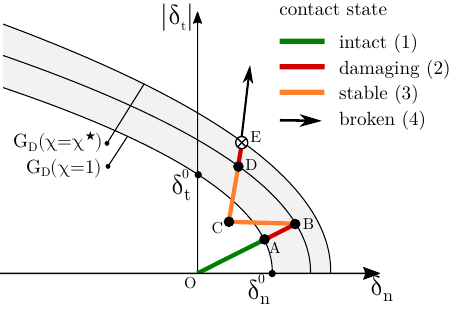
Figure 3. Evolution of the damage variable (D) in a paired inter- action for an idealized loading path, illustrating the four di ff erent cases of equation (5).